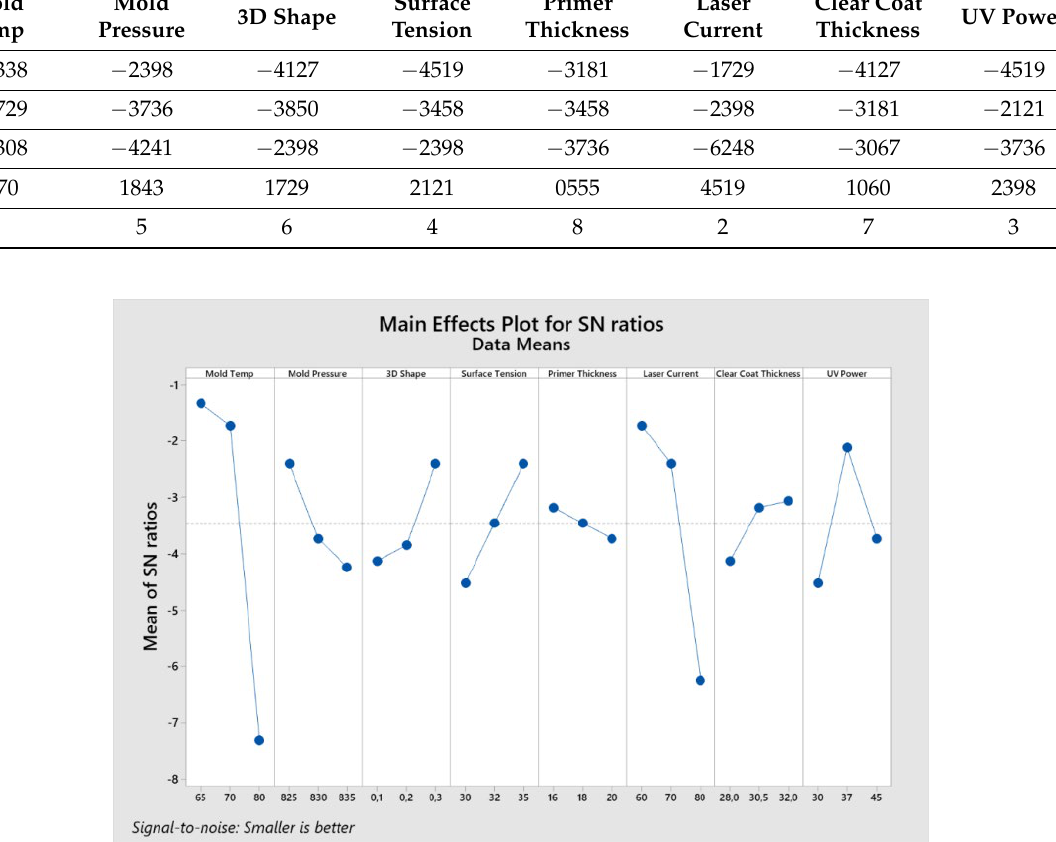
Figure 13. Main effects plot for Signal to Noise Ratios.